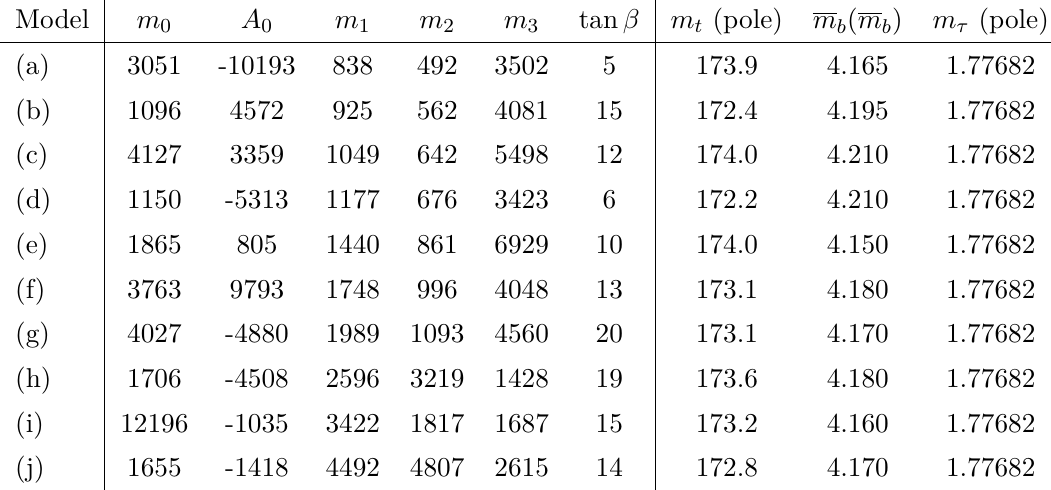
Table 6 . The SUGRA parameters sets used for RG analysis where the boundary conditions for the Yukawas for the top, bottom, and the tau are taken from table 5. In the analysis the GUT scale ranges from 8 . 8 × 10 15 GeV to 1 . 6 × 10 16